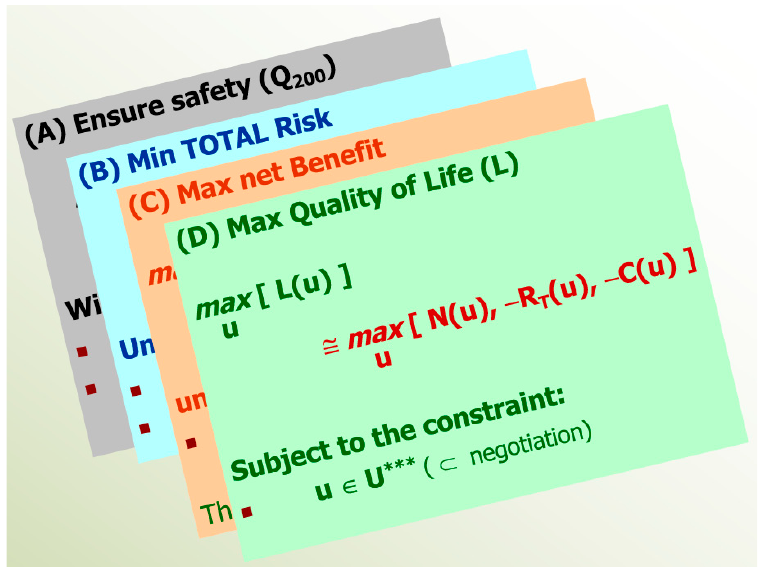
Figure 15. The problem that we, as a society, would actually have to approach where L stands for Quality of Life and the three objectives formulation (C: total costs; R T : total risk; N: nature value) is a preliminary, partial, formulation.